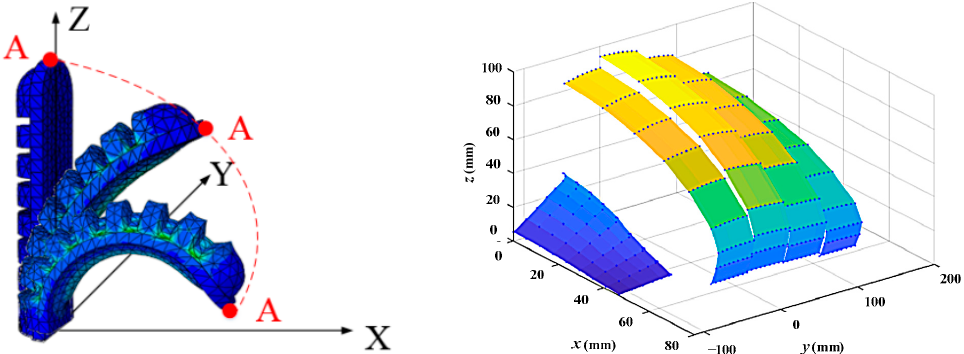
Figure 12. Workspace for SRGs.